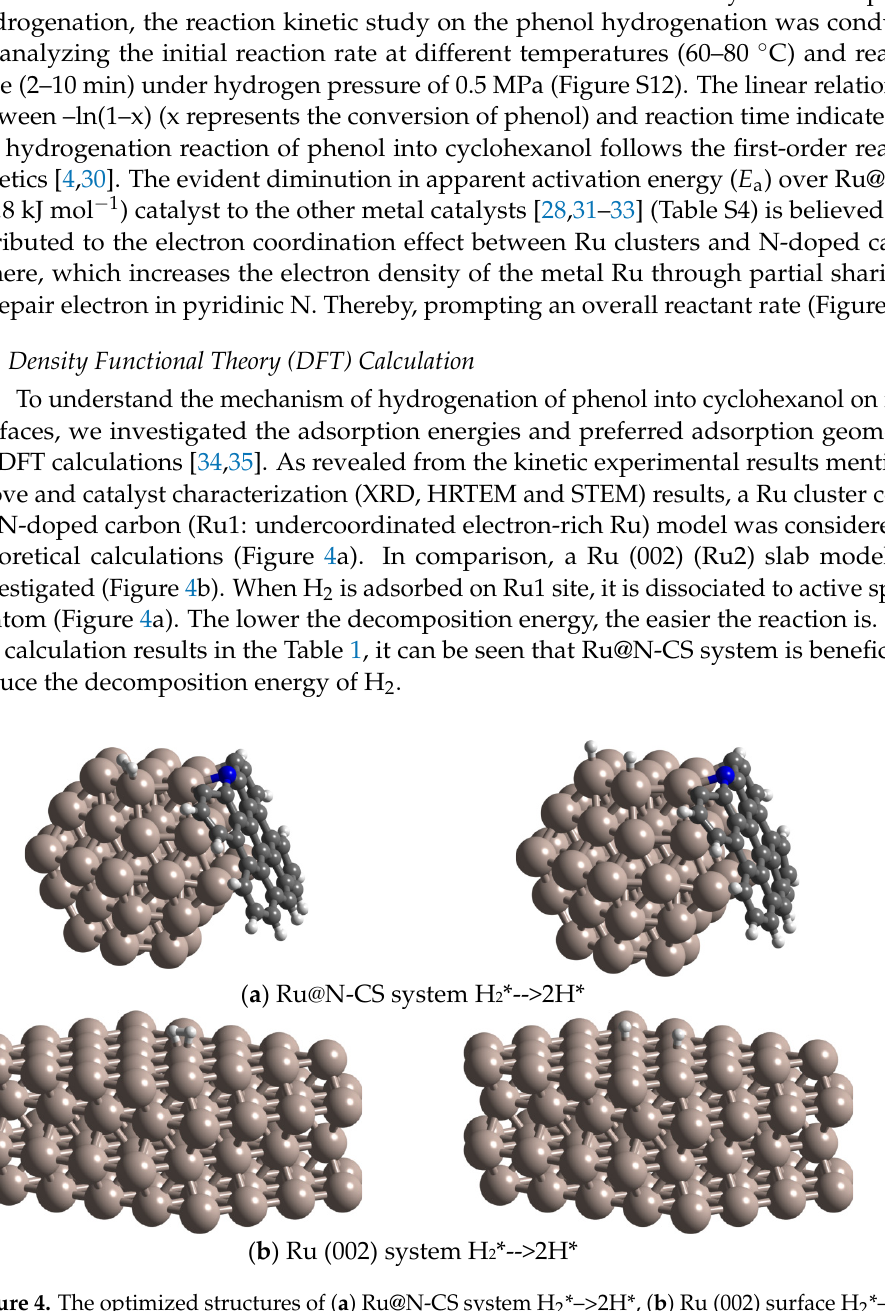
Figure 3. Study on the catalytic performance of phenol hydrogenation into cyclohexanol over Ru@N-CS catalyst. a, Proposed reaction mechanism for hydrogenation of phenol into cyclohexanol. b, Comparison of TOF values for Ru@N-CS catalyst and other Ru-based catalysts. c, Recyclability tests of phenol conversion over Ru@N-CS catalyst under the conditions: 0.1 g phenol, 10 mL water, mass ratios of phenol to Ru 13,000:1, 80 °C, 0.5 MPa H 2 , 30 min.